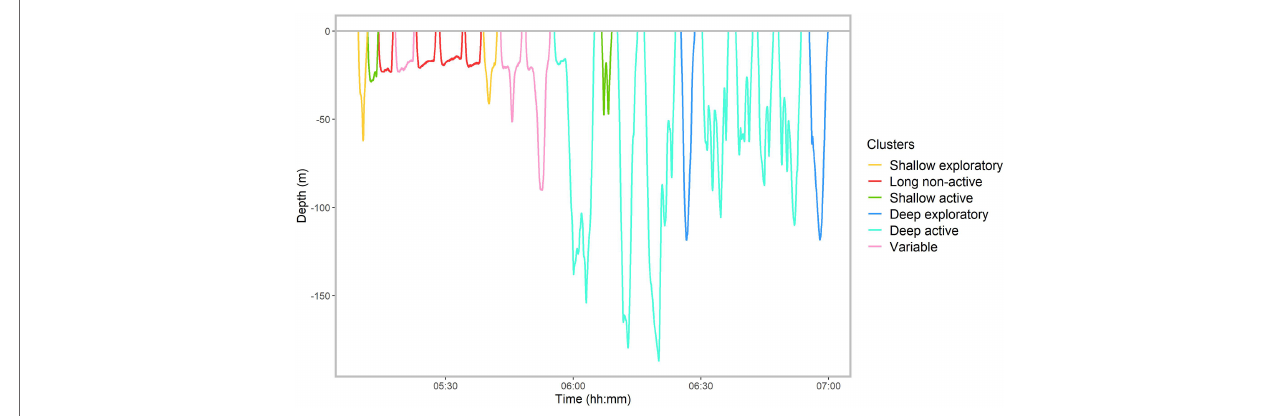
FIGURE 3 | A section of the dive profile of whale #19 with dives colored according to the dive type identified by the cluster